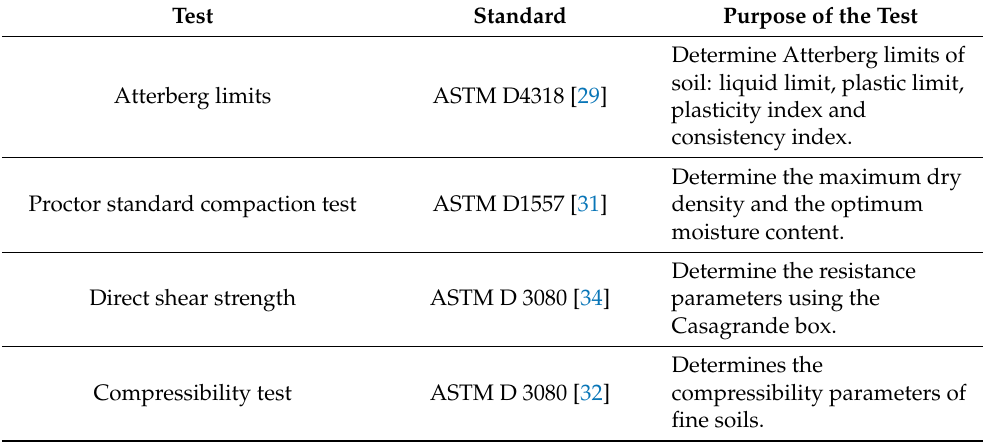
Table 4. Geotechnical Tests and Standards.